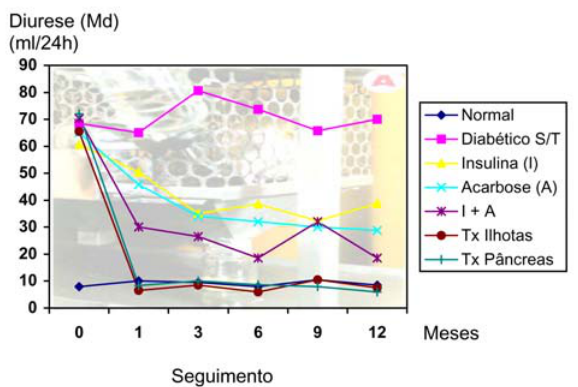
FIGURA 5 - Medianas da diurese (ml/24h) de animais nor- mais, diabéticos não tratados e diabéticos tra- tados com cinco diferentes tratamentos, du- rante 12 meses de seguimento